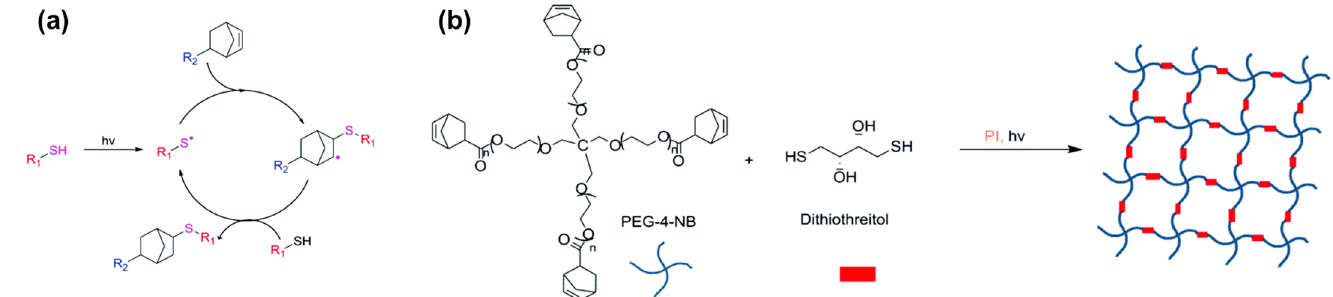
Figure 4. ( a ) Schematic of the thiol-ene reaction mechanism. ( b ) Schematic of the hydrogelation using 4-arm PEG-norbornene and DTT. Reprinted with permission from [49].